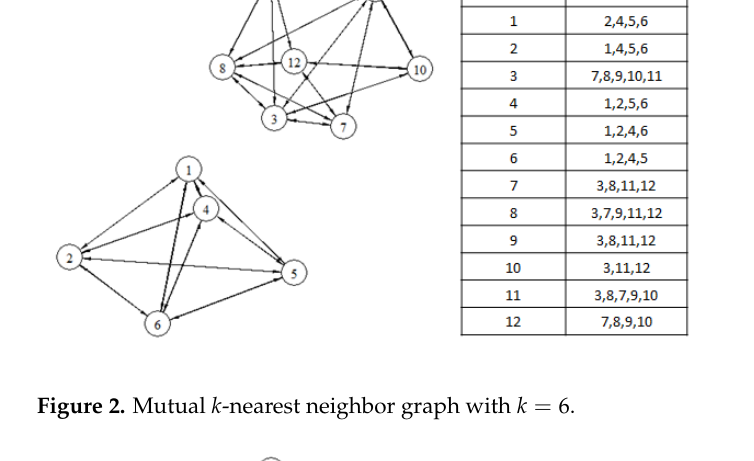
Figure 2. Mutual k -nearest neighbor graph with k = 6.